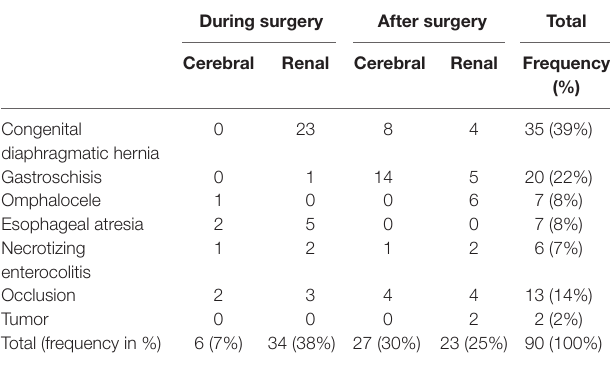
TaBle 4 | Cerebral and renal pathological rSO 2 values during or after surgery according to the pathology. During surgery after surgery Total